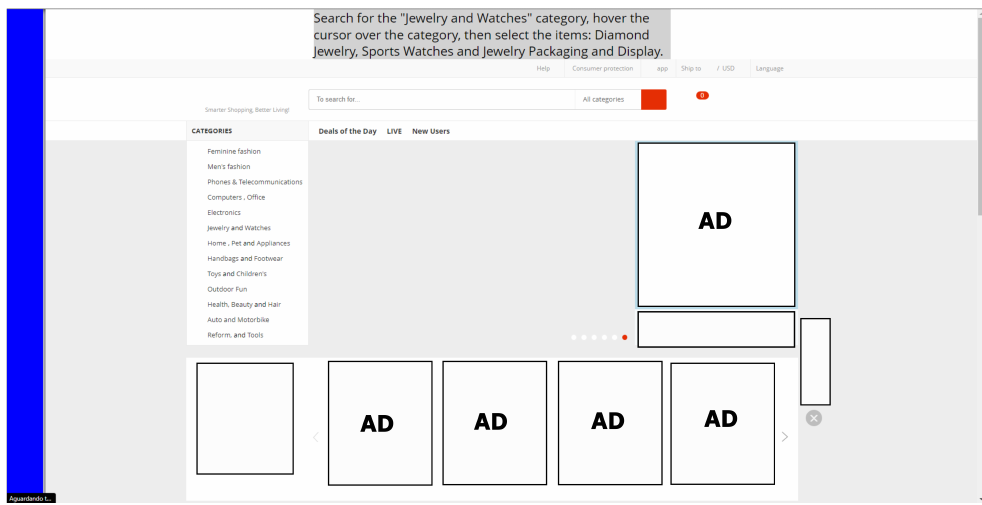
Figure 13. Simulated scenario 4 based on an e-commerce platform in a web service with